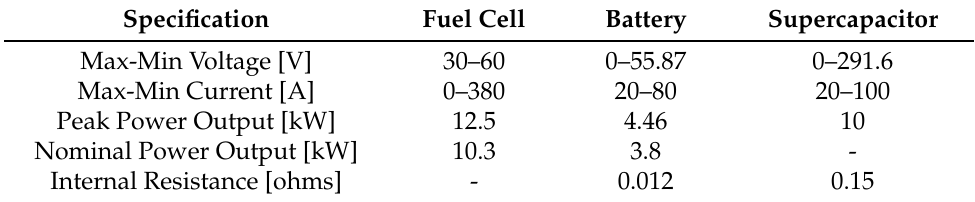
Table 1. Comparison of fuel cell, battery, and supercapacitor specifications [18].